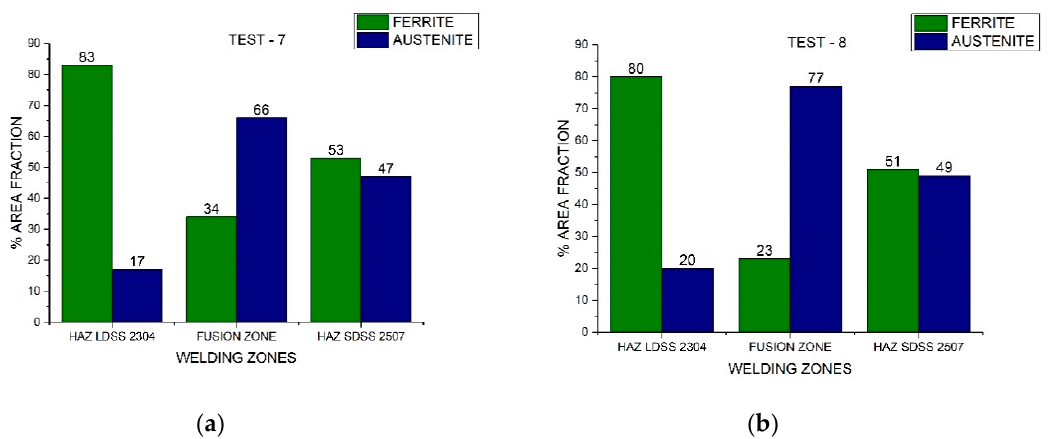
Figure 11. Area fraction through the distinct welded zones to 175 A: ( a ) Test #7 and ( b ) Test #8.